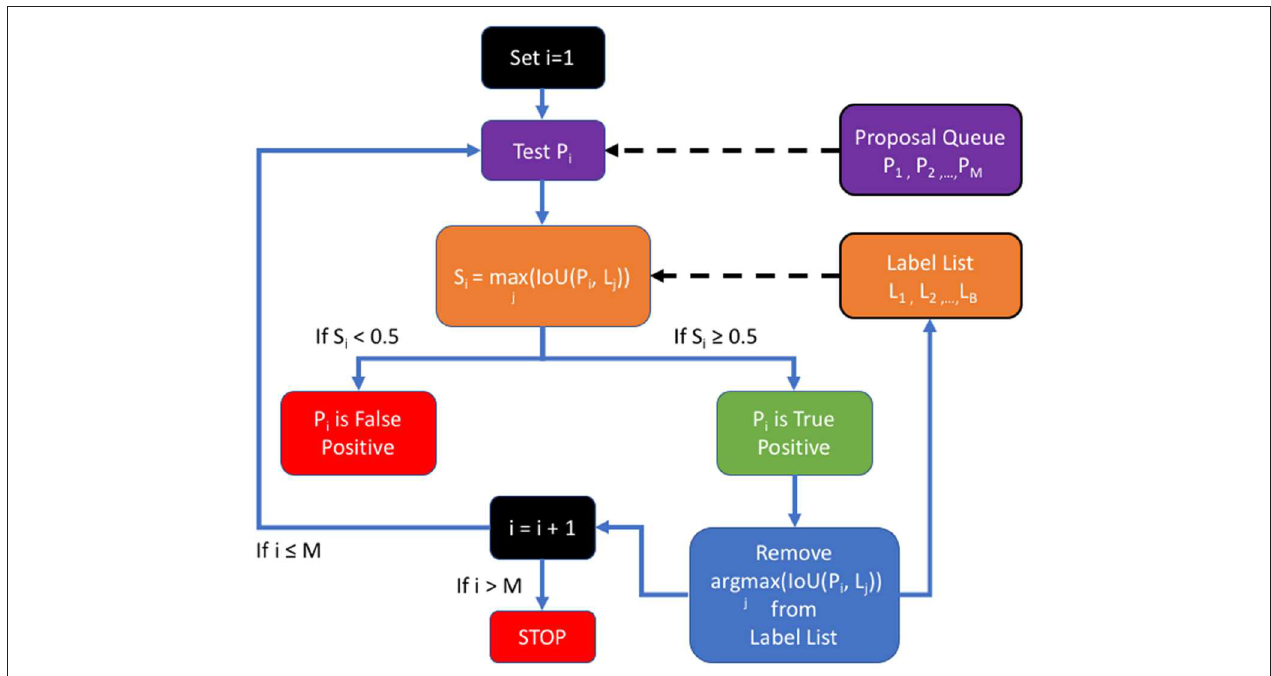
FIGURE 5 | The SpaceNet F 1 metric: a list of proposals is generated by the detection algorithm and compared to the ground truth in the list of labels.